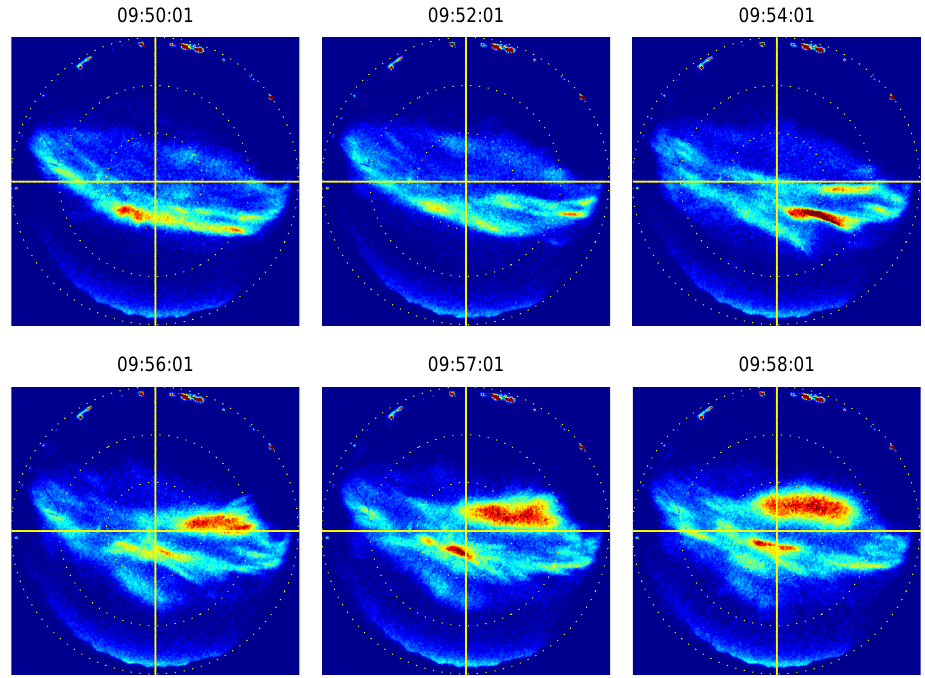
Figure 5 Fig. 5. Ny ˚Alesund ASC observations at 630.0nm for the interval 09:50–09:58 UT on 3 December 1997. The reference frame is zenith angle (dotted circles at 30, 60, and 90 ◦ ) and azimuth. Same format as in Fig. 4. The integration time is